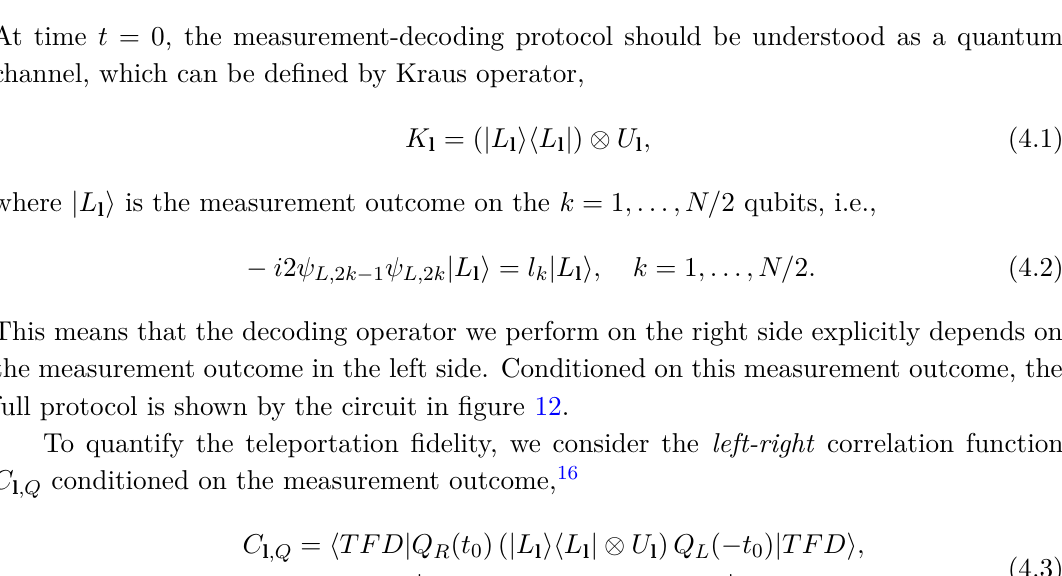
Figure 12. The circuit of the teleportation protocol. In the left side, an unknown state | ψ i is inserted in the past − t 0 , and a measurement is applied at t = 0 . The projection is indicated by the triangle with the measurement outcome l . According to the measurement outcome, a decoding operator, denoted by U l , is implemented in the right side at the same time t = 0 . After a time evolution t 0 , the state | ψ i is teleported to the right side. V denotes the time evolution operator. 3. At time t = t , the state | ψ i is teleported to the right 0